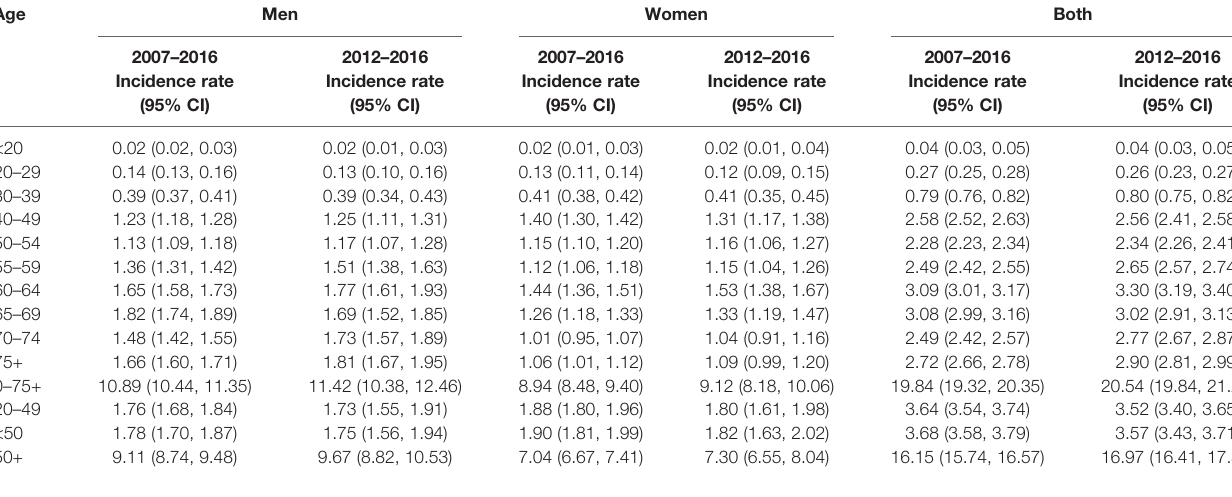
TABLE 3 | Age-standardized colorectal cancer incidence rates during the most recent years by gender, Saudi Arabia. Age Men